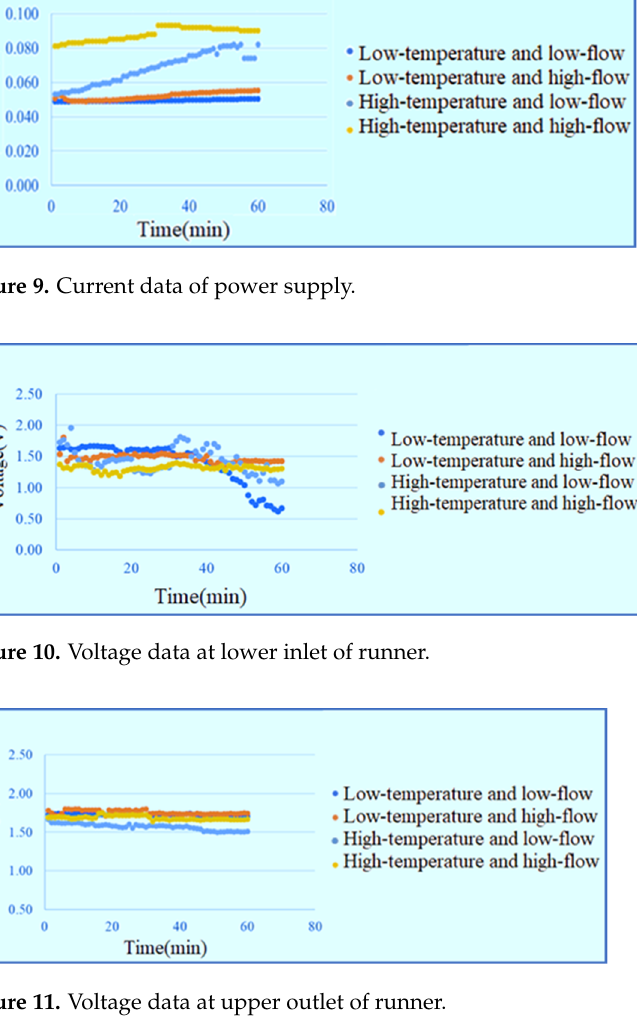
Figure 13. Current data at upper outlet of runner. 4.3. Temperature Distribution Inside Water Electrolyzer According to the data, the change of temperature at the inlet is more obvious in the reaction process, the outlet temperature changes smoothly, but the temperature is univer- sally high, because the water is filled into the PEMWE through the lower inlet, the water generates a little heat after reaction, the temperature rises. The temperature at upper outlet rises slightly as the water is transferred. According to the figures, the effect of waste heat is not obvious in hot environment, and the temperature change of high flow is relatively smooth, as shown in Figures 14–17 It can be seen from the figure that the temperature is very gentle when the flow is high, and the temperature is more unstable when the flow is low, and the figure shows that the temperature will not have much effect. Figure 14. Low-temperature low-flow outlet/inlet temperature curve diagram.